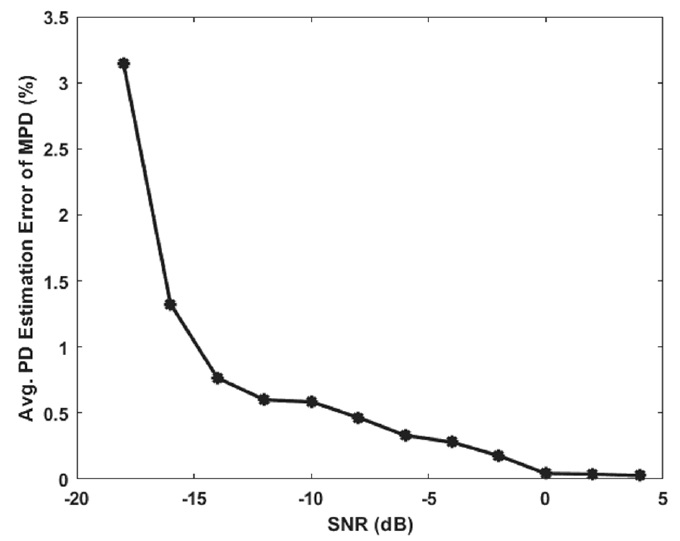
Figure 13. Average PD estimation error versus SNR for the MPD algorithm.